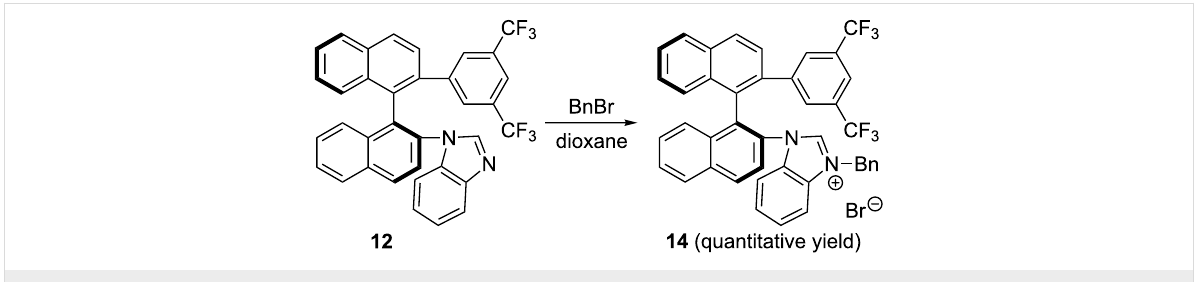
Scheme 3: Synthesis of benzimidazolium salt ( S )- 14